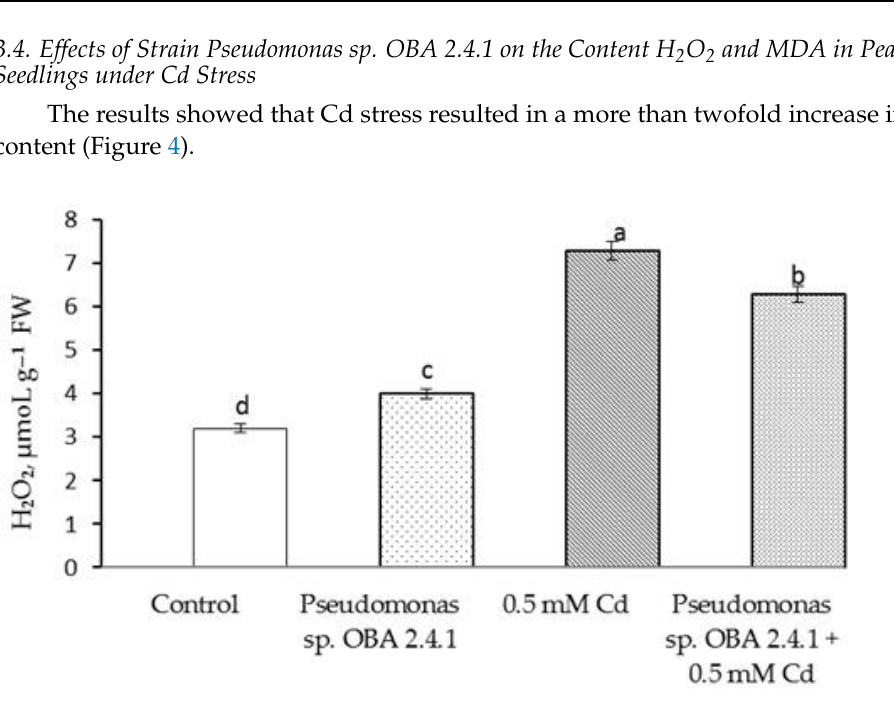
Figure 4. Effect of Pseudomonas sp. OBA 2.4.1 on the content of H 2 O 2 in 7-day-old pea seedlings under normal and Cd stress conditions. The bars indicate the mean values of three replicates ± SEM. Different lowercase letters indicate a significant difference between the means at the level of p < 0.05 (ANOVA, LSD test). Pseudomonas sp. OBA 2.4.1 did not affect the state of the membrane structures under normal